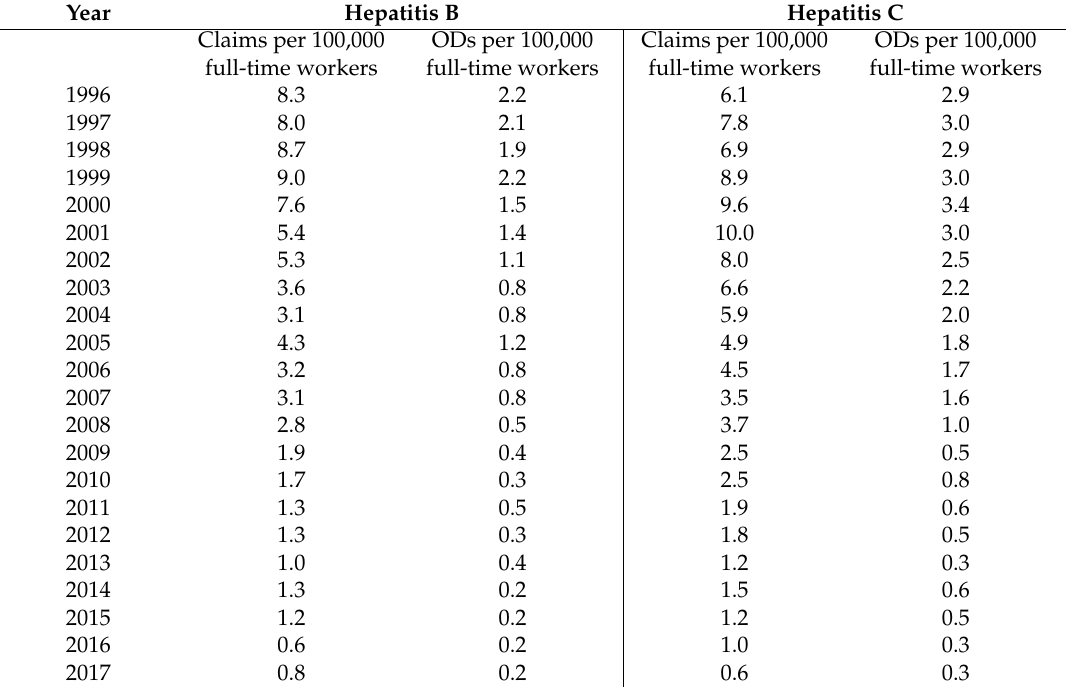
Figure 2. Hepatitis C: Claims and confirmed ODs from 1996 to 2017. Average confirmation rate for hepatitis C virus (HCV): 39.7% (total number of claims: 4761; total number of confirmed ODs: 1361)